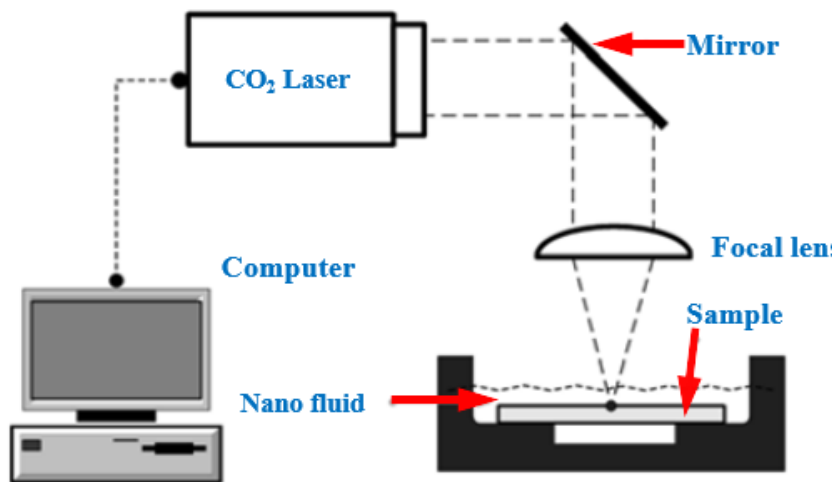
Figure 1. Schematic diagram of the nanoliquid-assisted laser drilling process.